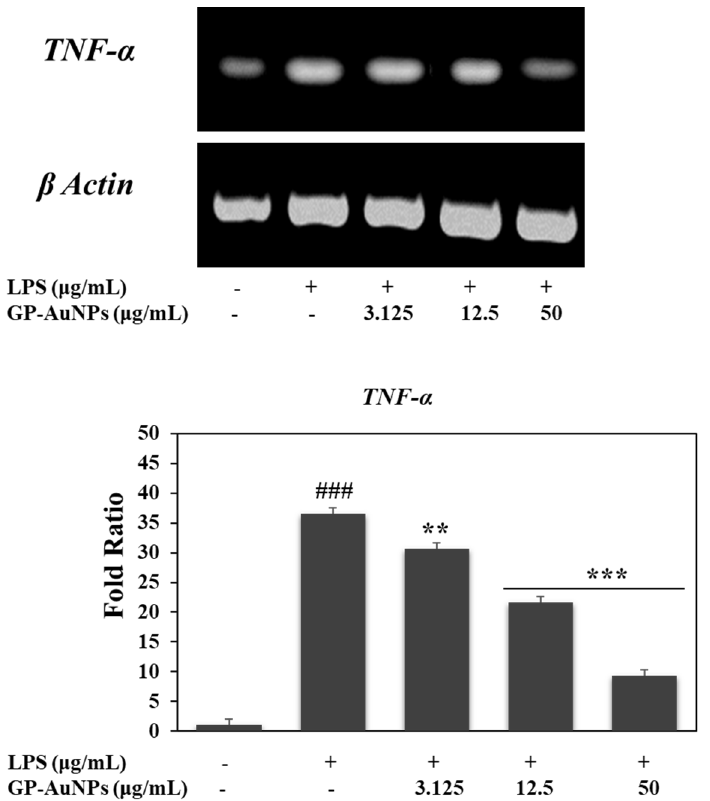
Figure 13. Effect of GP-AuNPs on the transcriptional activation of the inflammatory gene TNF- α in RAW 264.7 cells. RAW 264.7 cells were pretreated with the indicated concentrations GP-AuNPs for 1 h, and then stimulated with LPS (1 μ g/mL) for 24 h. Subsequently, total RNAs were extracted, and the mRNA expression levels were determined by RT-PCR analysis and compared with those of β - actin. The data shown are representative of the mean values of three independent experiments ± SD. ** p < 0.01, *** p < 0.001 as compared with the group treated with LPS, and ### p < 0.001 as compared with the control.